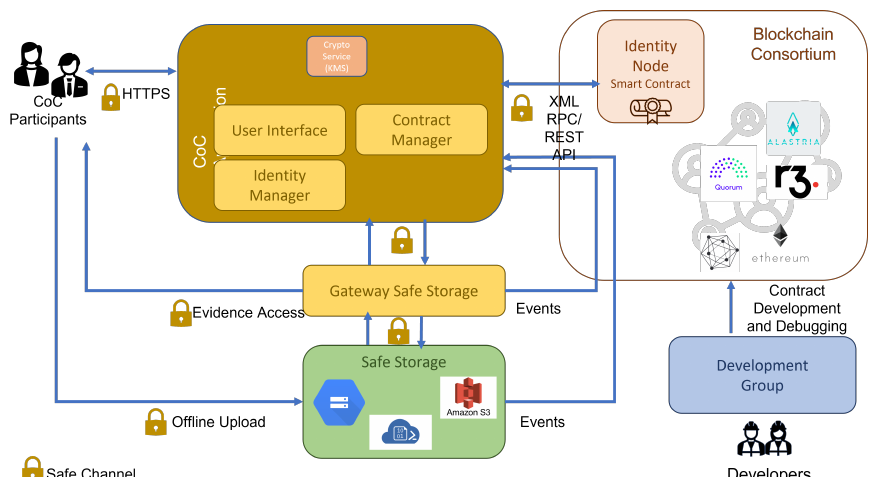
Figure 3. Distributed Architecture.